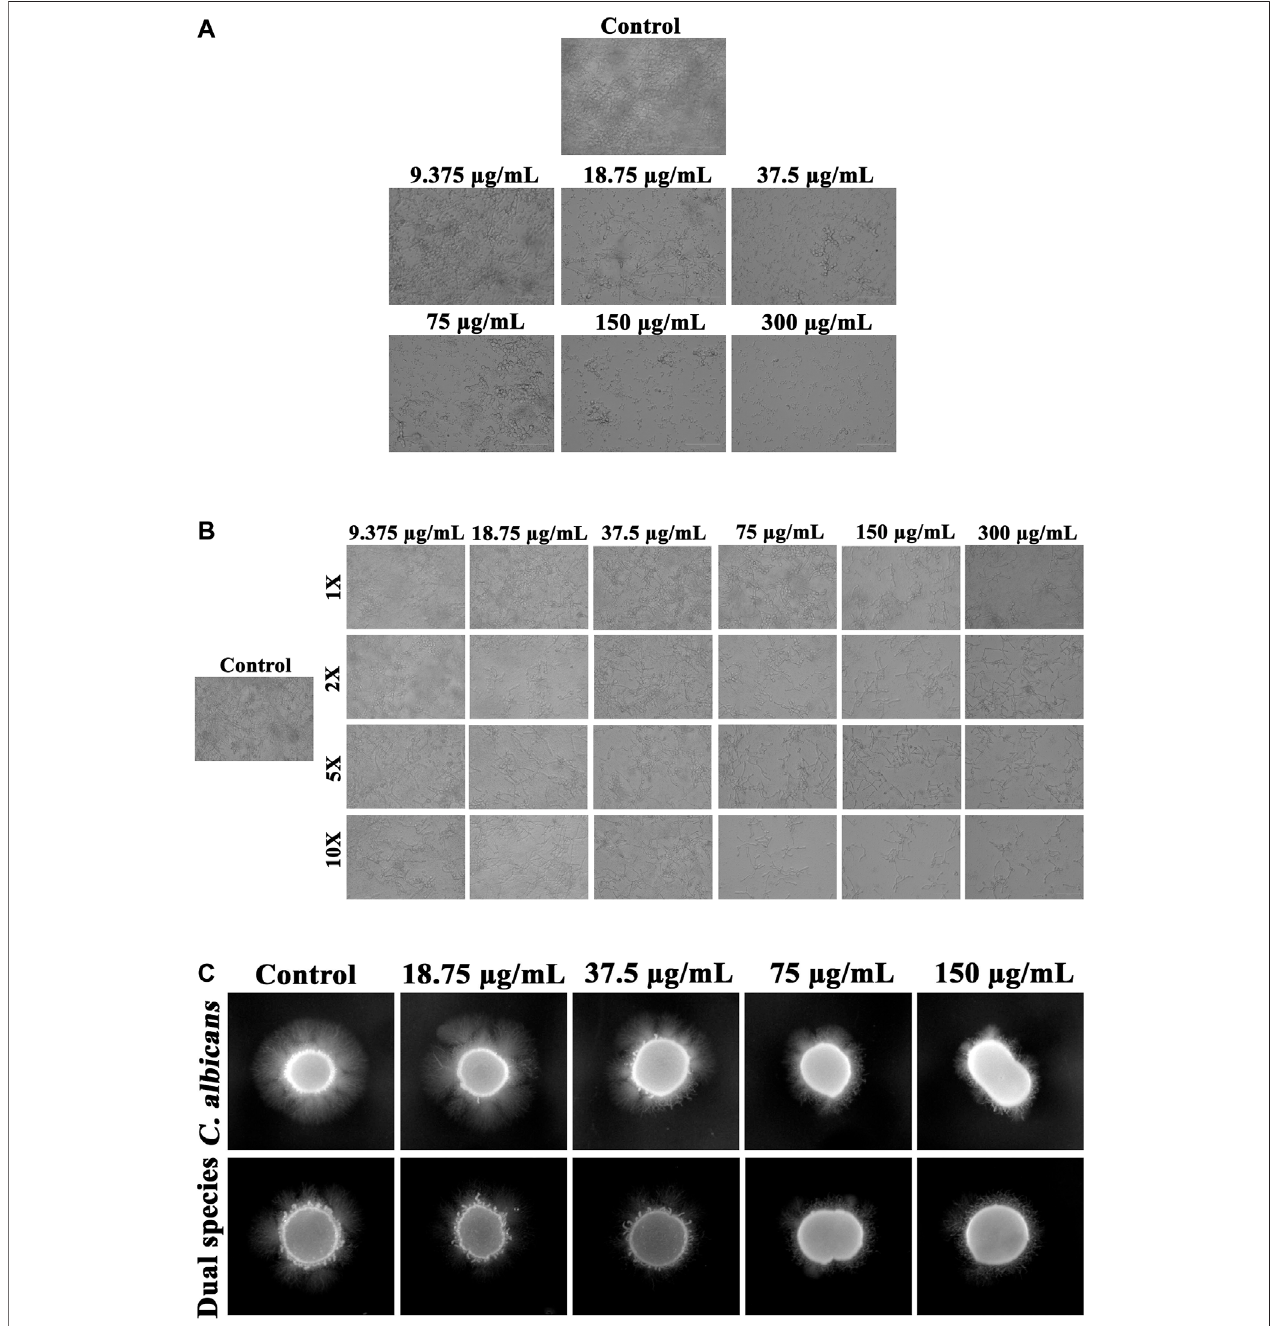
FIGURE 3 | In fl uence of thymol on fungal morphogenesis of C. albicans in single and dual species state. (A) Thymol, in a concentration-dependent manner, suppressedthetransitionofyeastcellstohyphalform. (B) Transitionofhyphalcellstoyeastmorphogenesiswasaugmented byincreasingconcentrationsofthymol. (C) Filamentation with the supplement of FBS was ef fi ciently repressed by thymol in both single and dual species state.